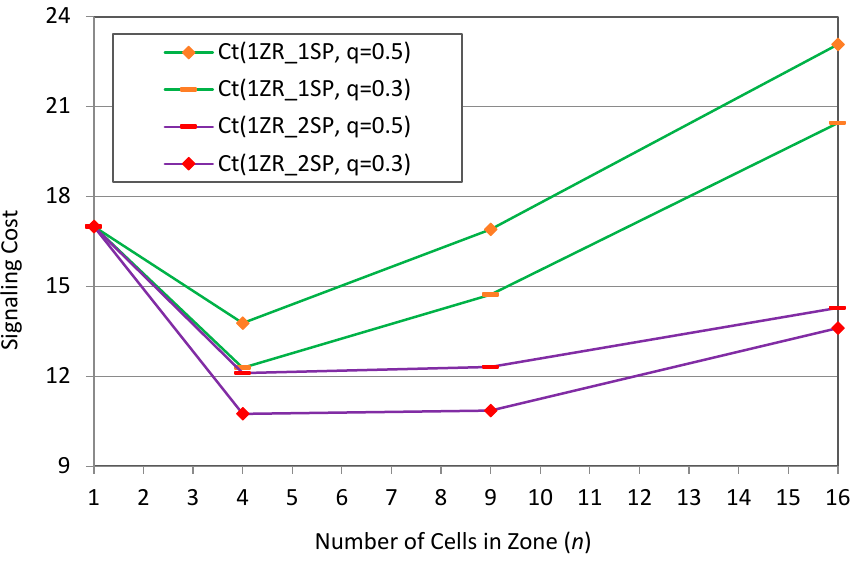
Figure 14. Effect of 2-step paging ( λ m = 3, λ c = 1).